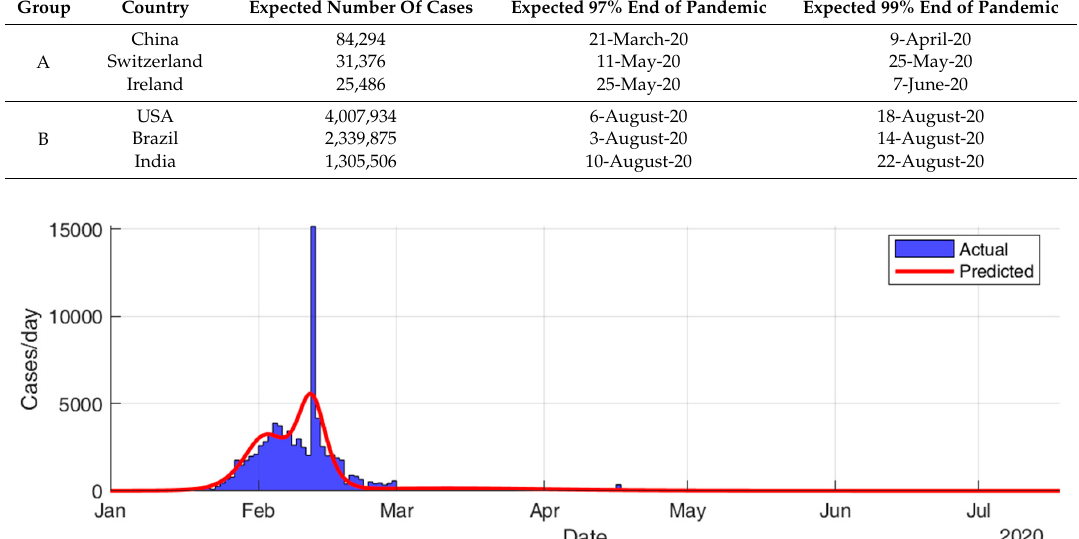
Figure 15. Prediction results for infection cases in China.